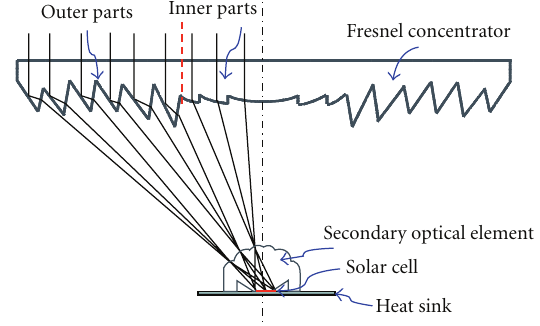
Figure 1: Sketch map of compound Fresnel-R lens for CPV